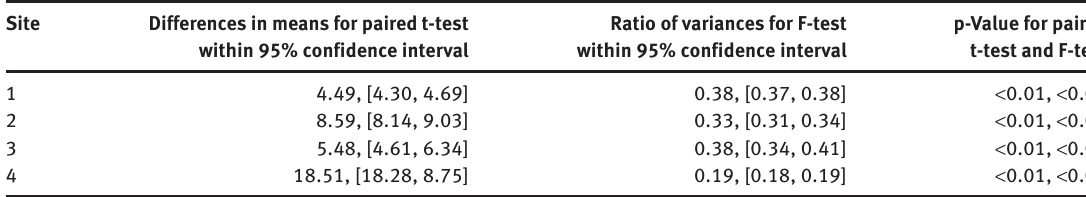
Table 3: Comparisons of Differences between Means and Variances Using Paired t-Test and F-Test, p-Value with 95% Confidence Level at Different Sites for the Classes [Motorcycle (C1) and Cars (C2)].